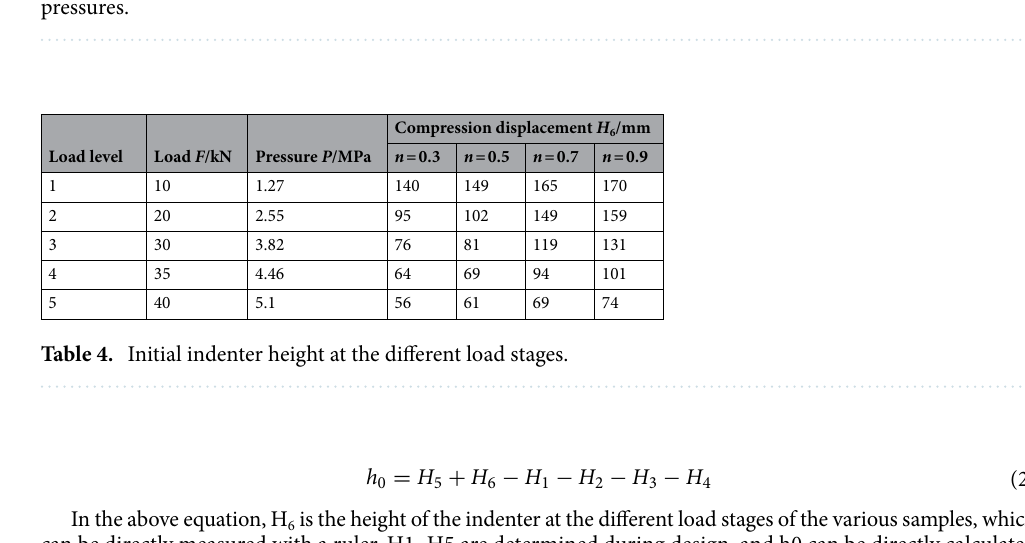
Table 3. Fitting relationship between the quality of the migrating particles and time under the various osmotic pressures.